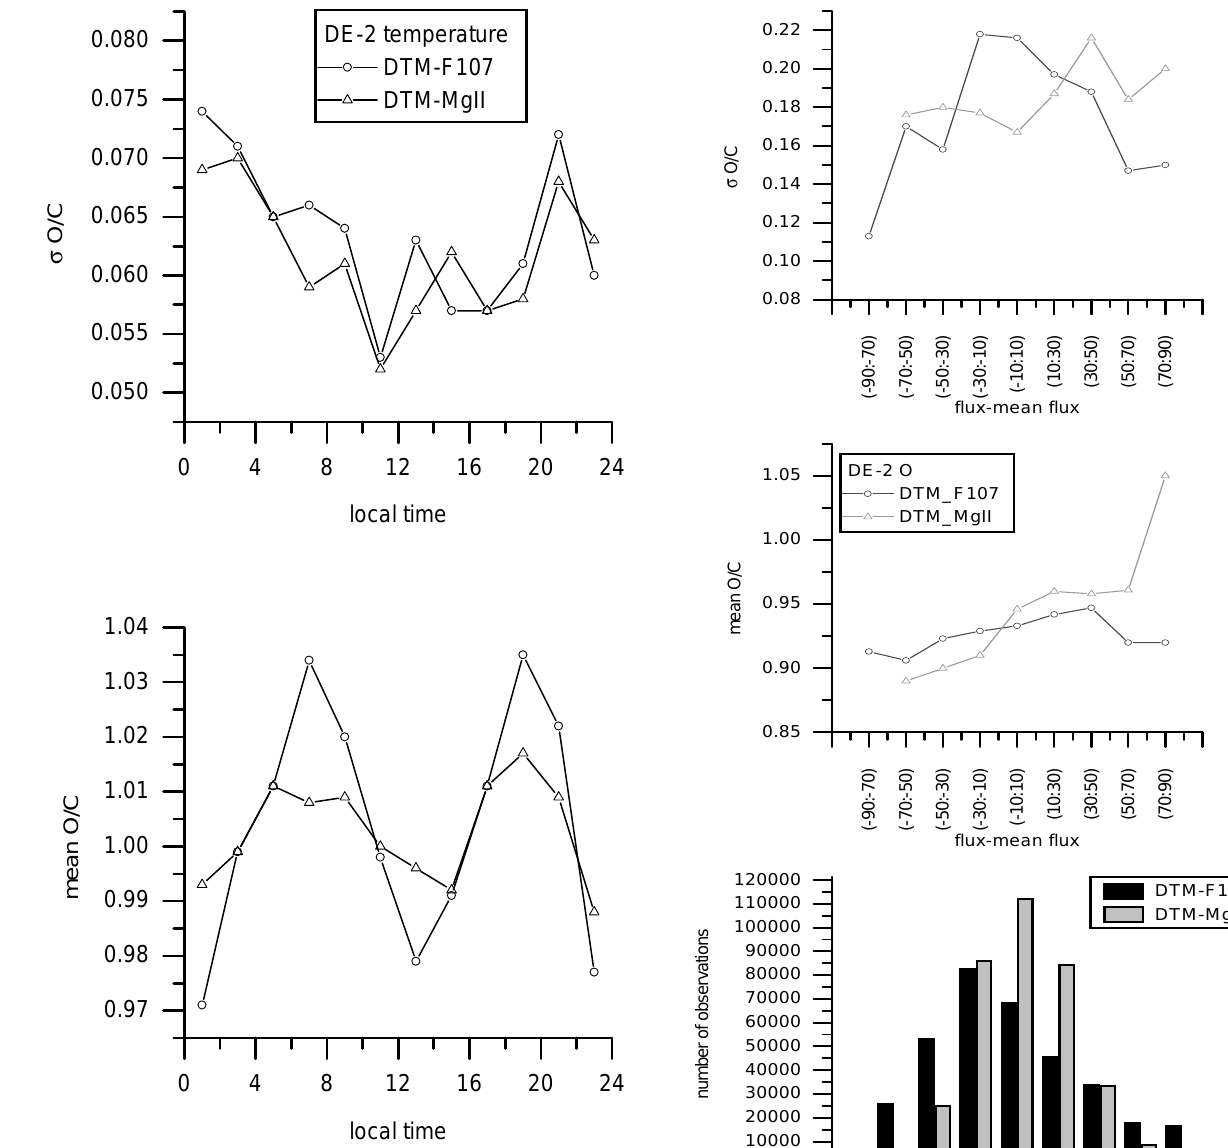
Fig. 5. The mean and scatter of the DE-2 temperature residuals presented in local time bins.